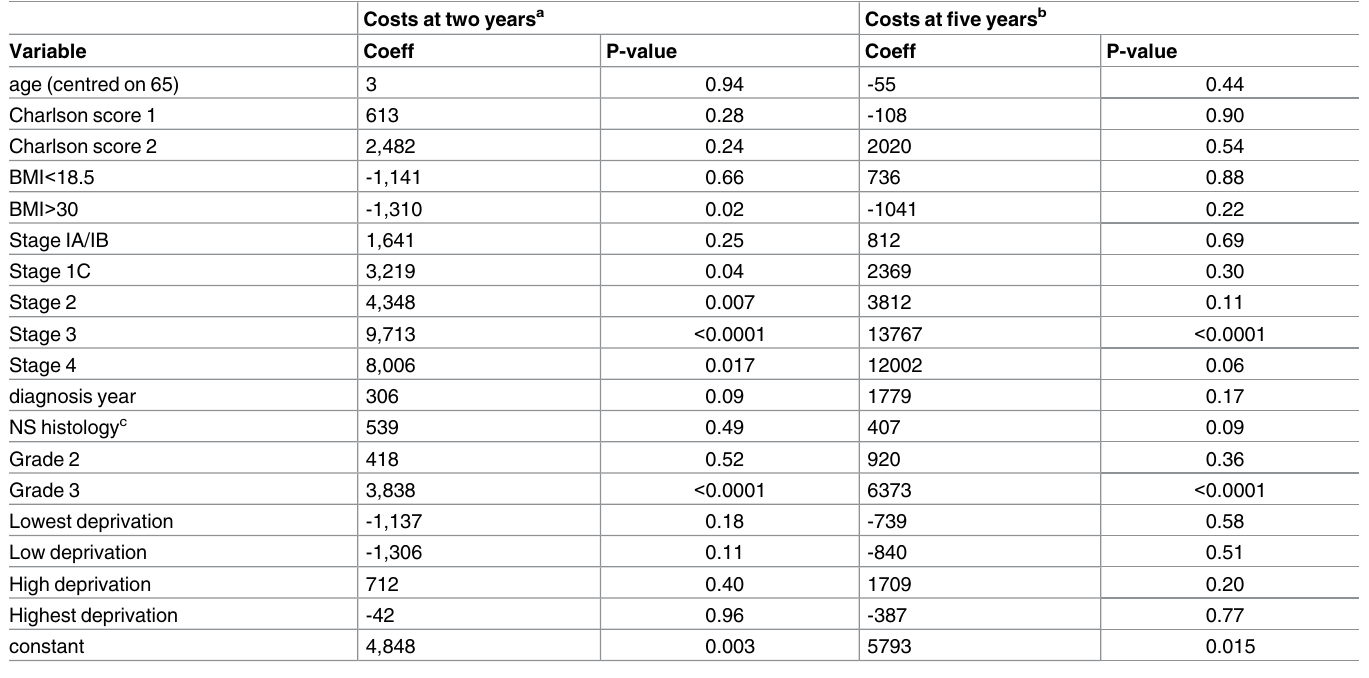
Table 3. Regression analysis of uncensored costs at two years and all costs at five years (after imputation) following EC diagnosis. Costs at two years a Costs at five years b